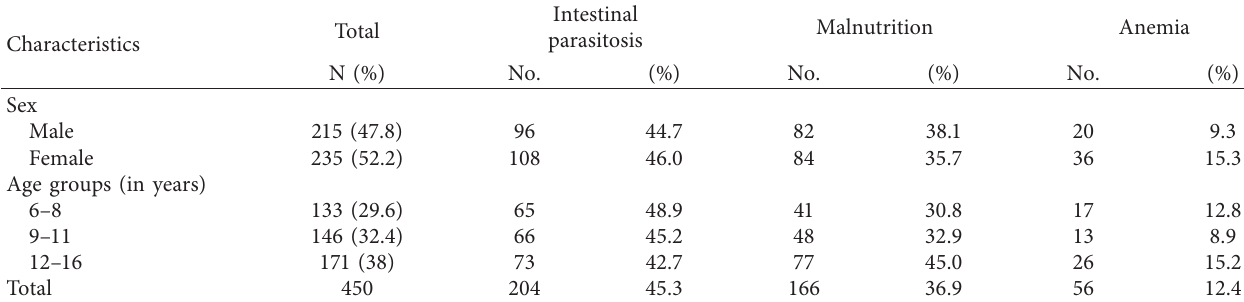
Table 1: Prevalence of intestinal parasitosis, malnutrition, and anemia in Ghindae area, Eritrea, 2018 ( n � 450). Characteristics